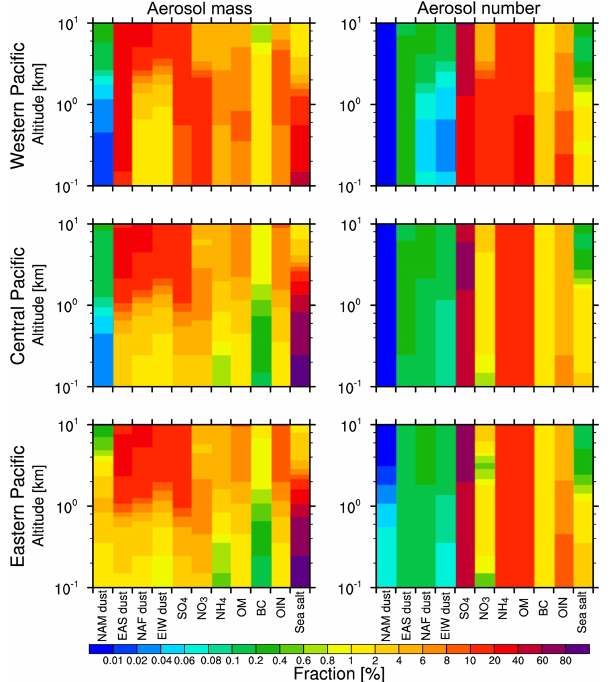
Figure 6. Vertical distribution of fractional contributions to aerosol composition mass and number over the western, central, and eastern Pacific from the WRF-Chem simulation averaged for 2010–2014.